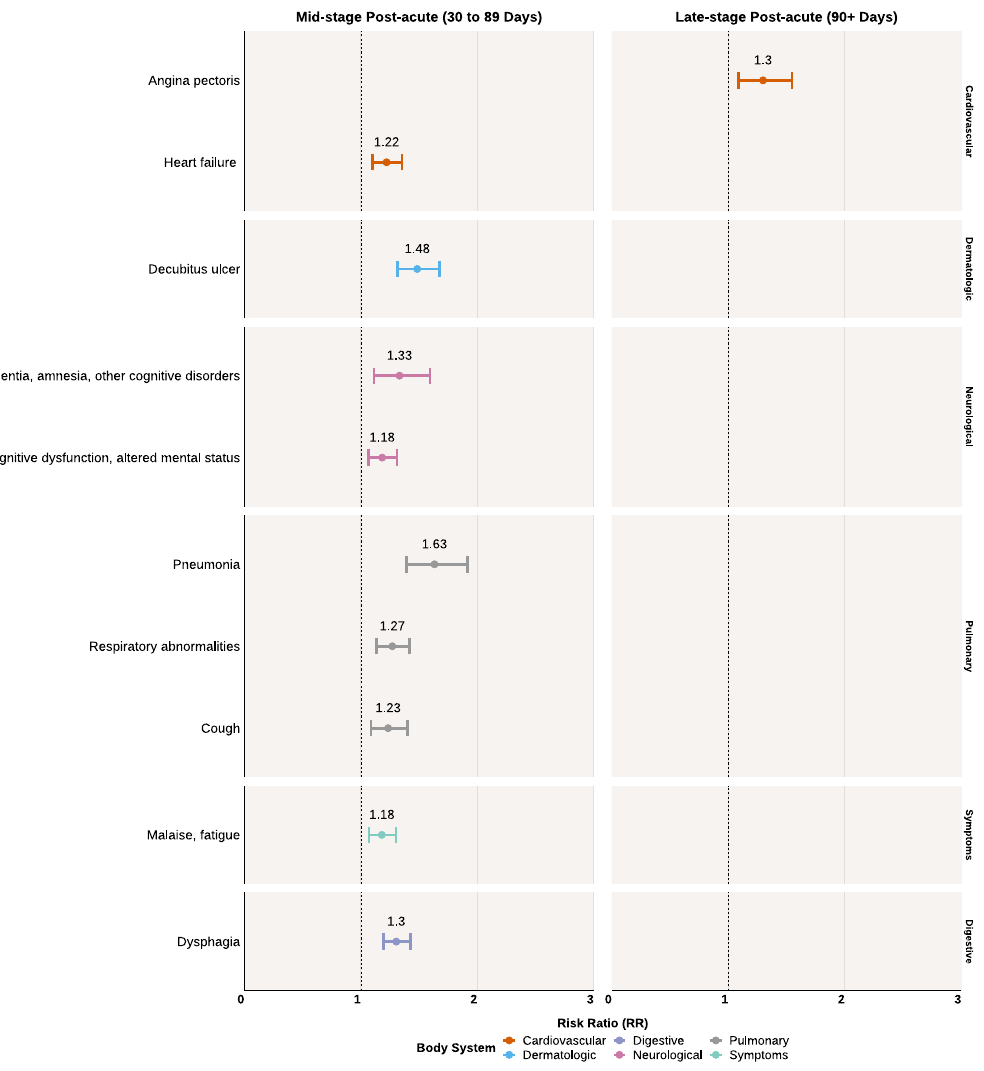
Fig. 3 Statistically signi fi cant risk ratios and their 95% con fi dence intervals of health conditions in the inpatient COVID-19 cohort compared to the control inpatient cohort. Left panel shows diseases of increased risk at the mid-stage post-acute period (30 to 89 days after initial infection) among the inpatient COVID-19 cohort. Right panel shows diseases of increased risk at the latestage post-acute period (90 + days after initial infection). P values were corrected for multiple comparisons with a 5% false discovery